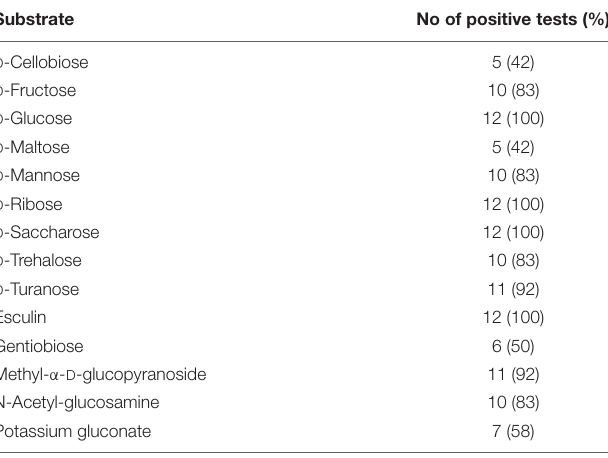
TABLE 1 | Substrate utilization by the 12 Leuconostoc carnosum strains assessed with API 50 CH. Substrate No of positive tests